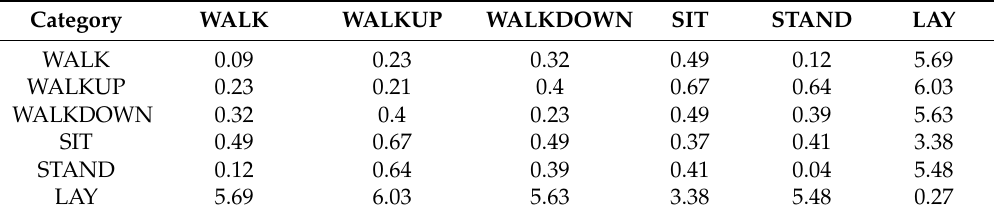
Table 4. The specific inner and outer class divergence of the Extracted feature.